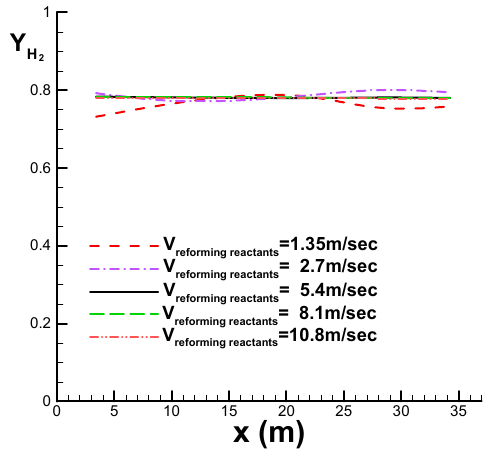
Figure 9. Comparison of the average mole fractions of hydrogen at the reforming tube outlets using different inlet velocities of the reforming reactants.